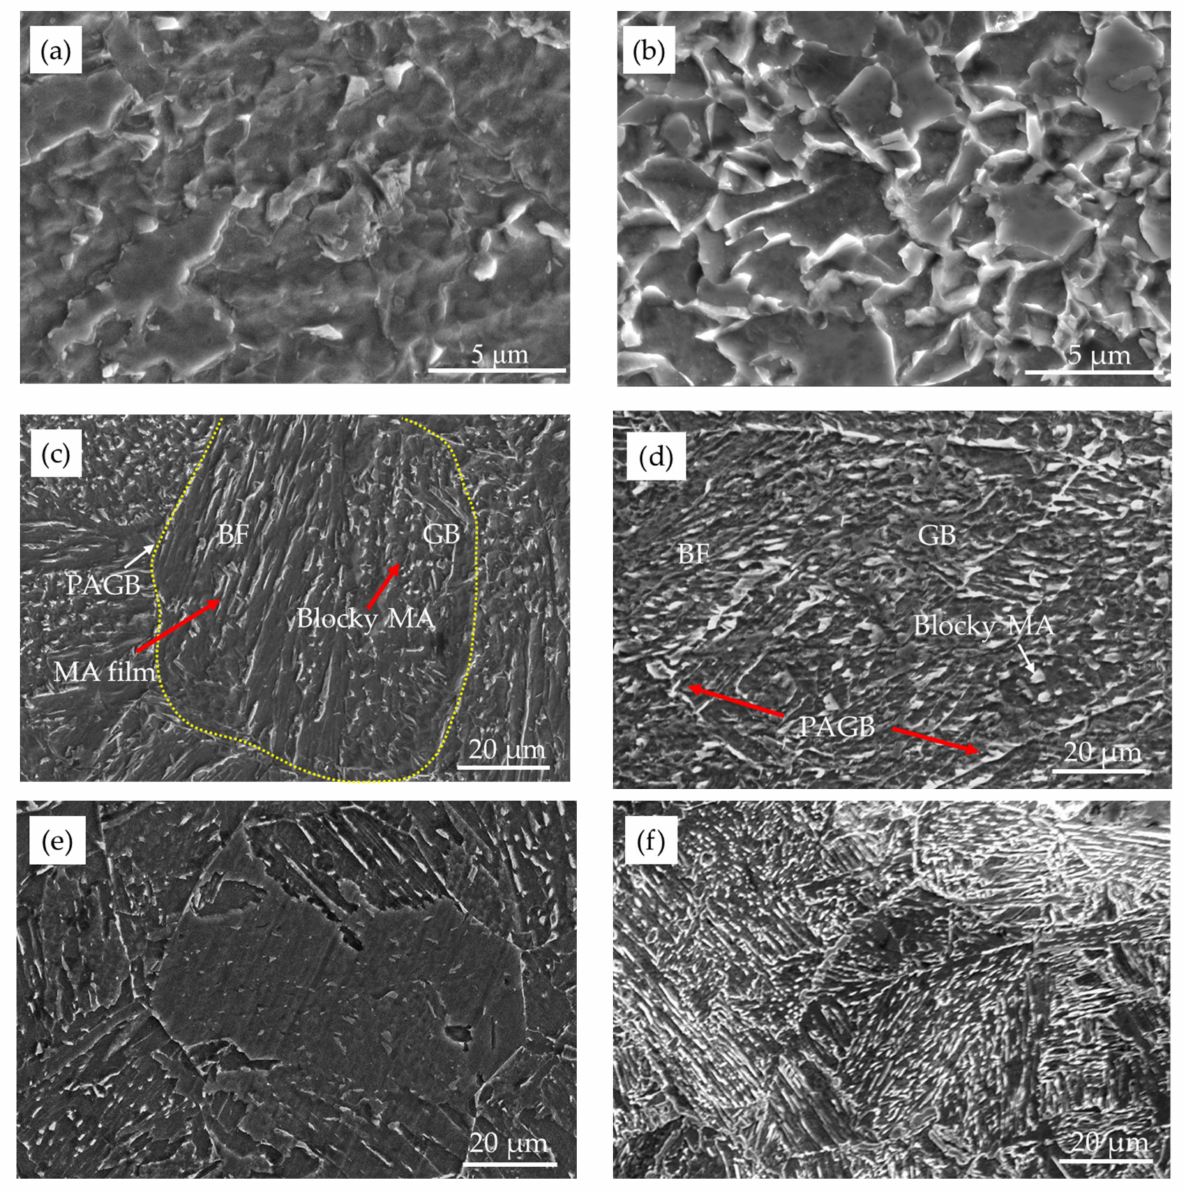
Figure 3. SEM of the different positions of the X80 steel welded joint. ( a ) base metal; ( b ) FGHAZ; ( c ) CGHAZ; ( d ) ICCGHAZ; ( e ) thermal simulated CGHAZ; ( f ) thermal simulated